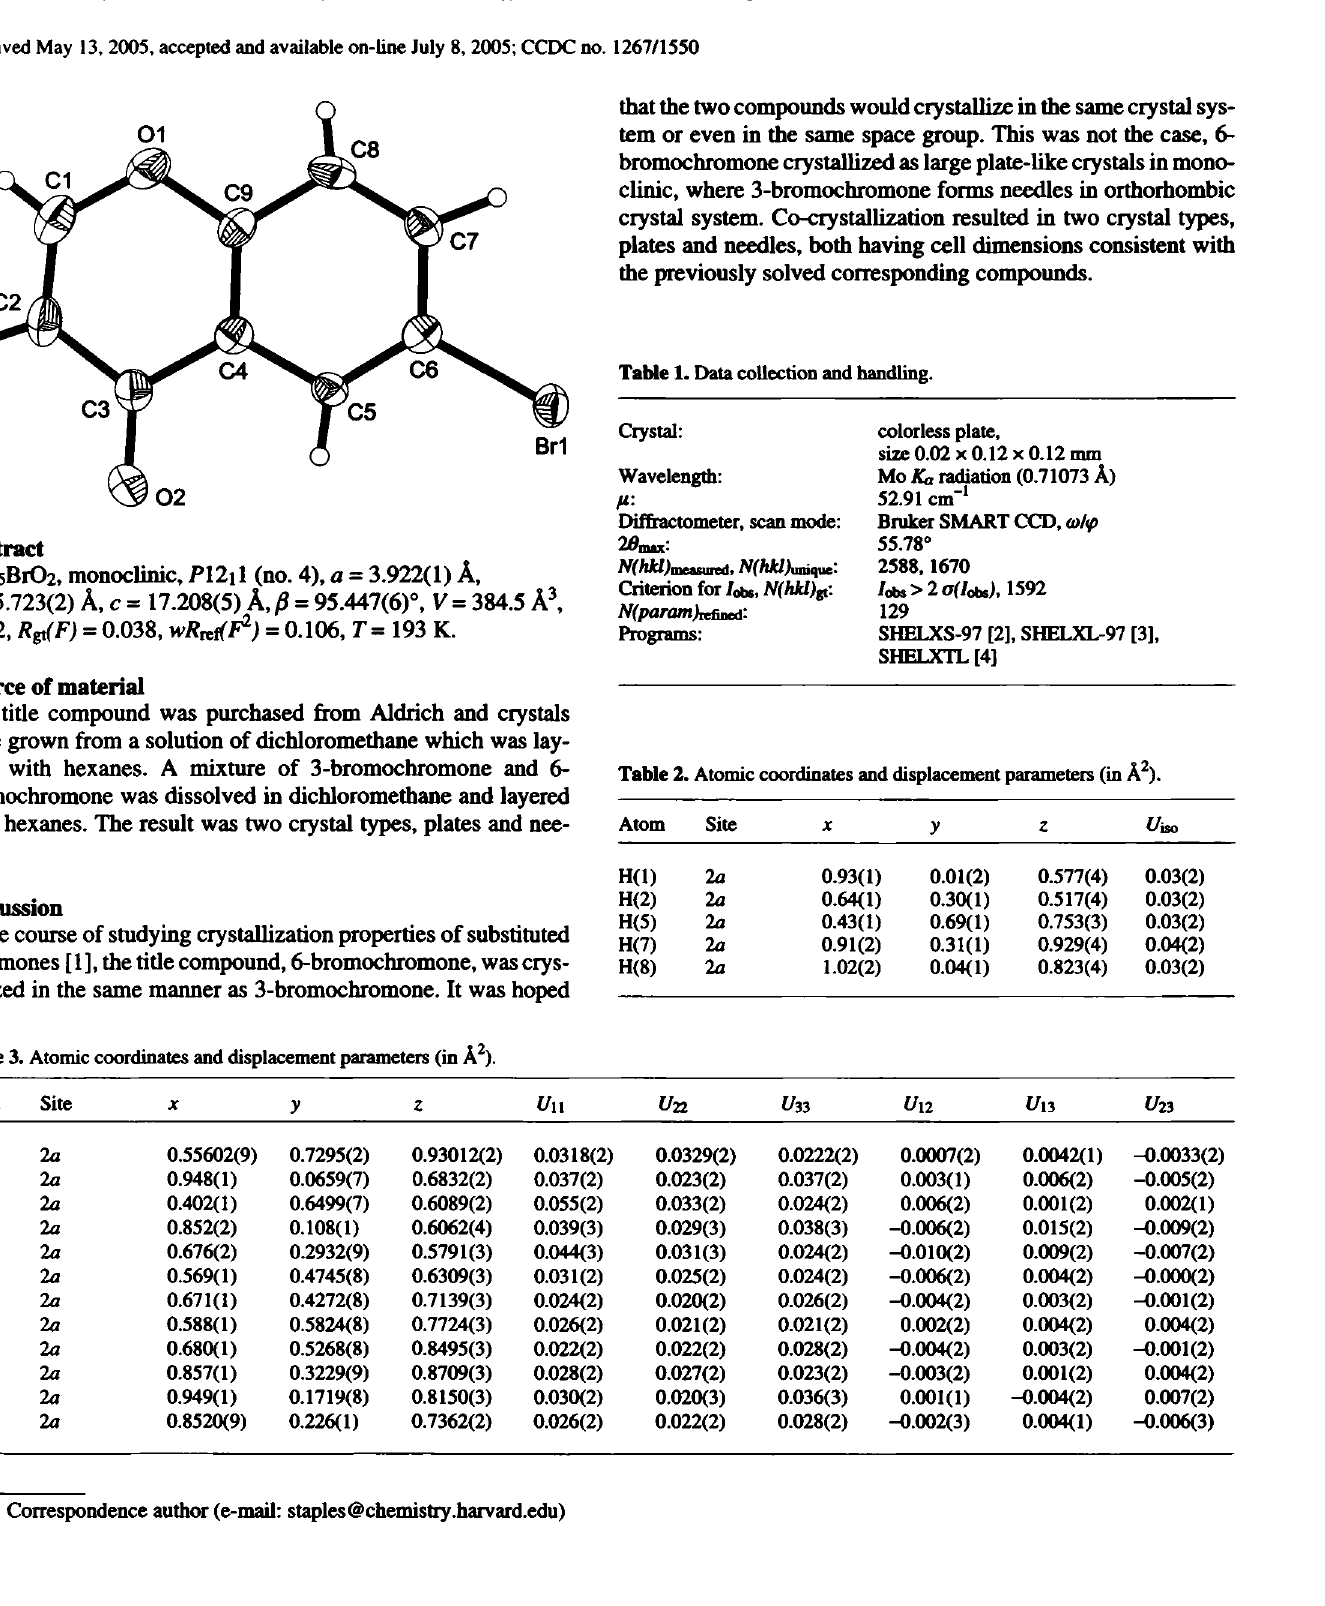
Table 3. Atomic coordinates and displacement parameters (in A 2